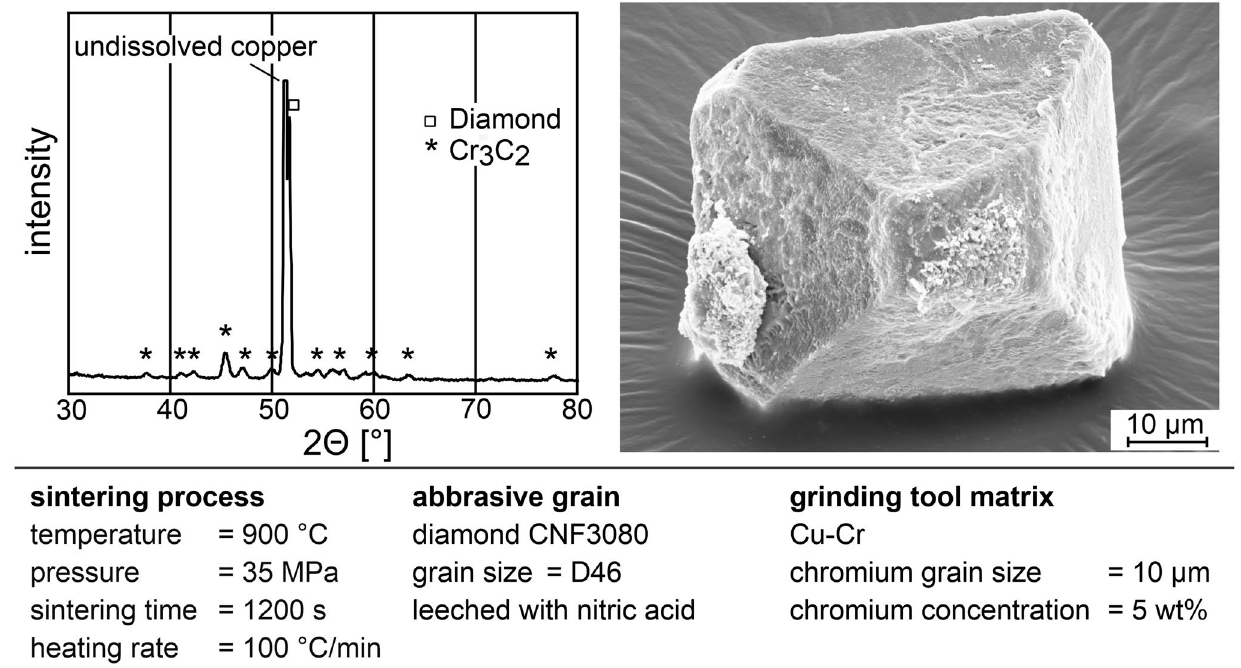
Fig. 8 Qualitative analysis of the composite sample with energy- dispersive X-ray spectroscopy. Through the spectra analysis, cop- per, carbon, chromium, and gold (from the coating) can be iden- tified (top). An EDS-Mapping combined with a line scan shows a